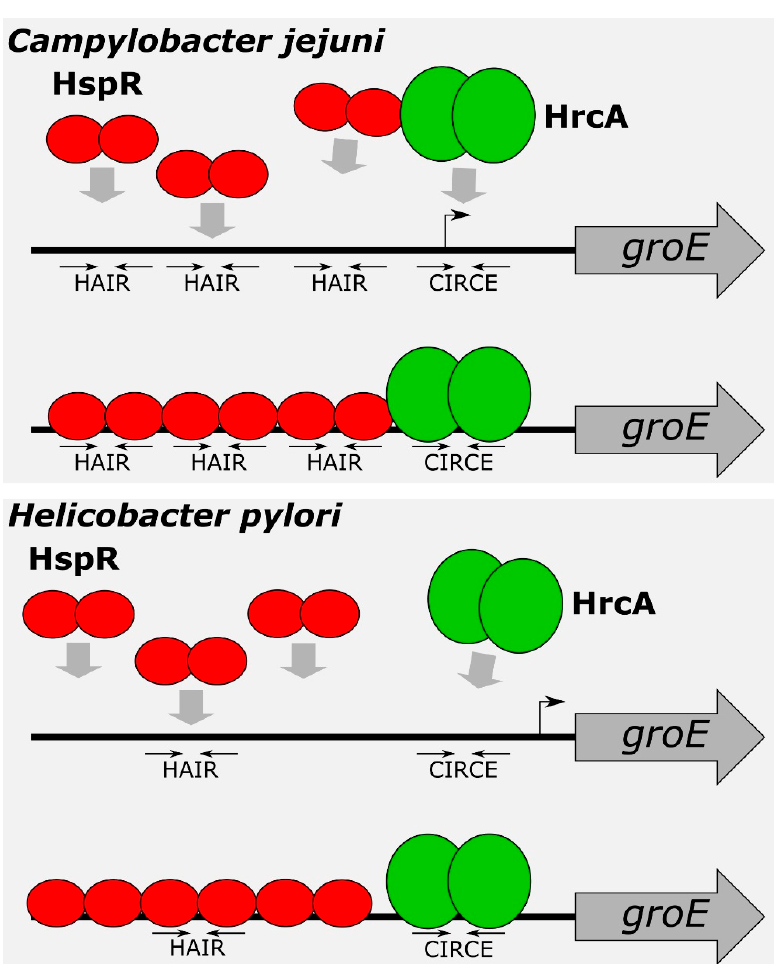
Figure 8. Model for P gro co ‐ regulation by HspR and HrcA in C. jejuni (upper panel) and H. pylori (lower panel). In C. jejuni , HspR binds to multiple HAIR sequences located upstream the core promoter, covering an extended DNA region. High ‐ affinity central HAIR inverted repeat is crucial for HspR ‐ promoter interaction, which enhances the repressor interaction with the flanking low ‐ affinity sites. HrcA binds to CIRCE ‐ like motif located on the transcription start site. In C. jejuni , HspR and HrcA exhibit a mutual cooperative mechanism of DNA binding and a direct protein–protein interaction. In H. pylori , a dimer of HspR binds with high affinity to a single HAIR consensus sequence. This first binding event could act as a nucleation center, promoting cooperative binding of two HspR dimers on the flanking regions, likely recognizing still uncharacterized sequence determinants [14]. HrcA binds to a CIRCE element located in the core promoter. However, in H. pylori, HspR and HrcA bind to their operators in an independent manner and do not interact.